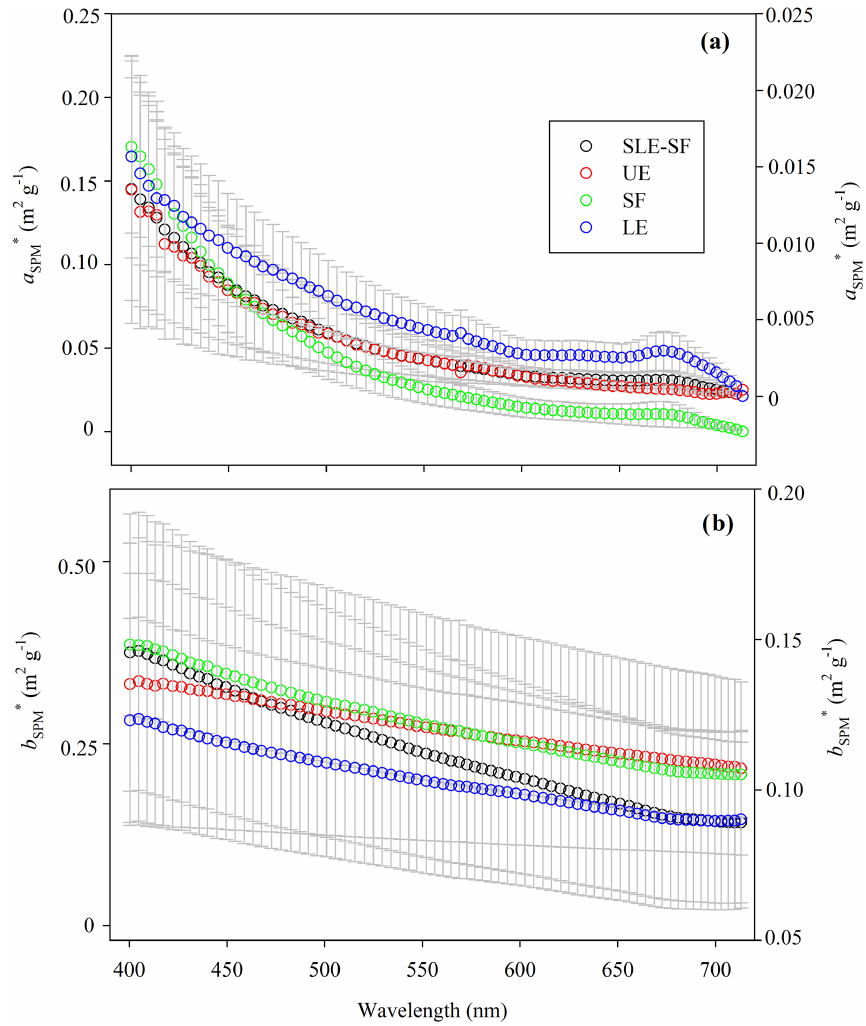
Figure 2. Spectral variation of mass-specific optical coefficients for total SPM. (a) a SPM ∗ (left axis SF; right axis UE, LE and SLE-SF) and (b) b SPM ∗ (left axis SF and SLE-SF; right axis LE and UE). Each bar is the arithmetic average ± 2 standard errors, as computed for SLE-SF (black circles), UE (red circles), SF (green circles) and LE (blue circles) sub-regions. The numbers of observations for UE, SF and LE sub-regions are 3, 5 and 15